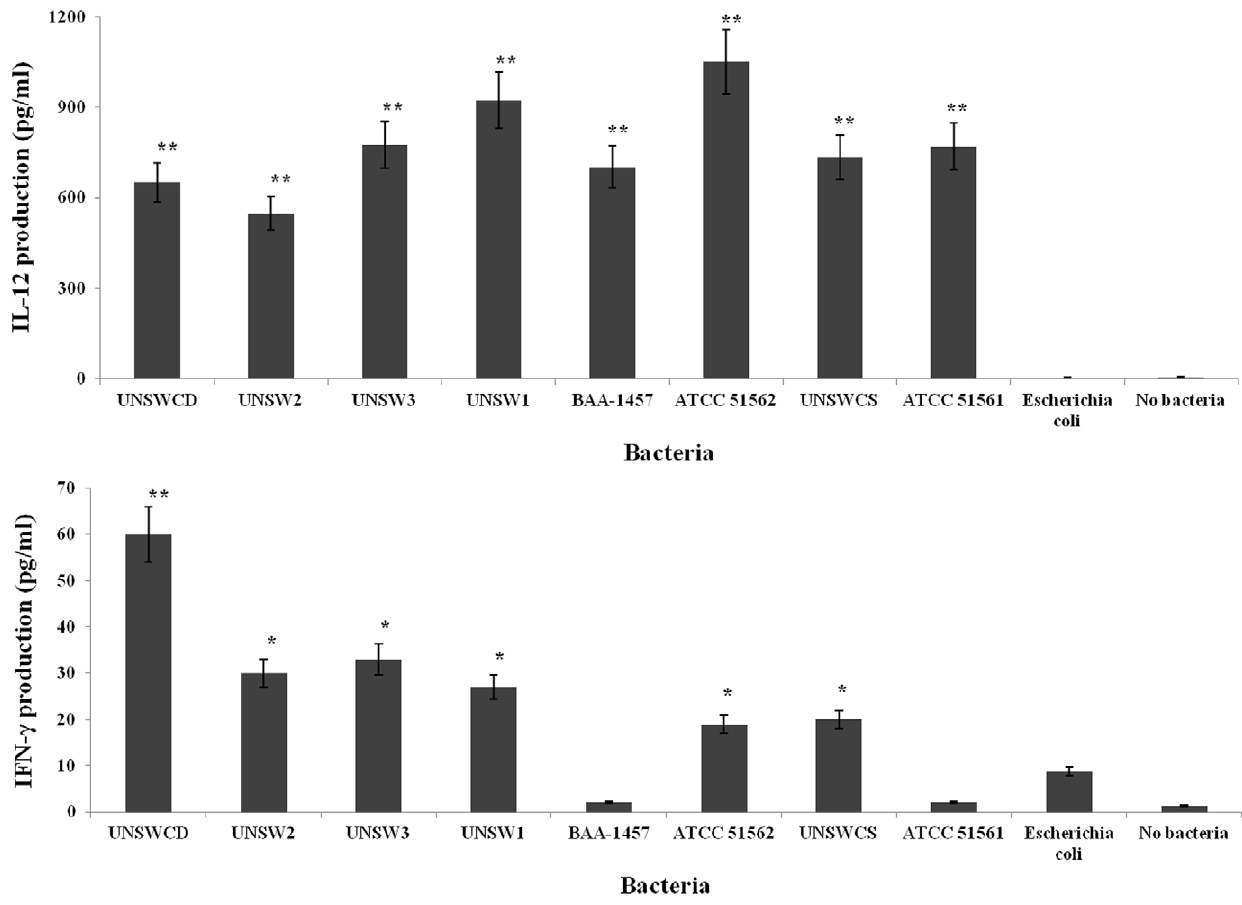
Figure 7. Levels of interleukin-12 and interferon- c produced by the human monocytic leukemia cell line THP-1 following infection with Campylobacter concisus strains and Escherichia coli K-12. * represents P , 0.05; ** represents P , 0.01. Data of three independent experiments 6 standard error of the mean.